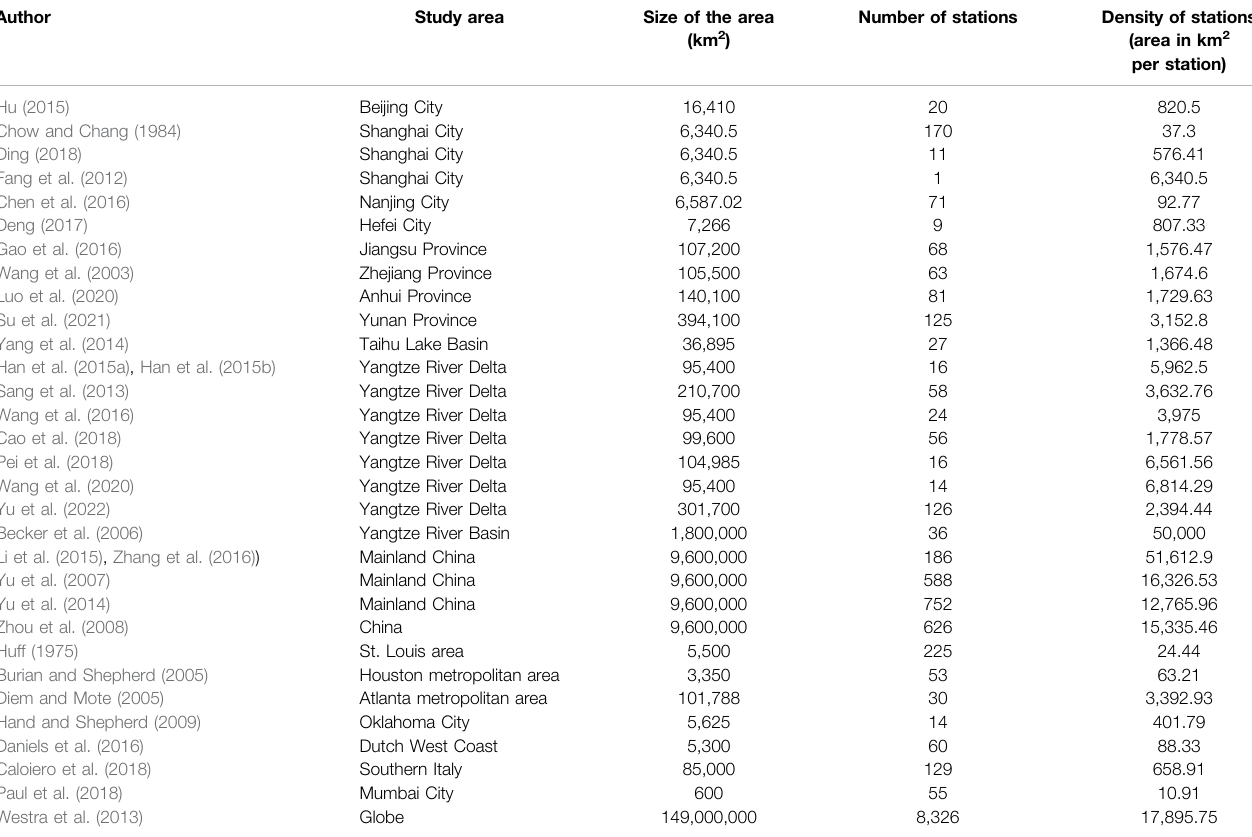
TABLE 1 | Summary of the characteristics of the case study on